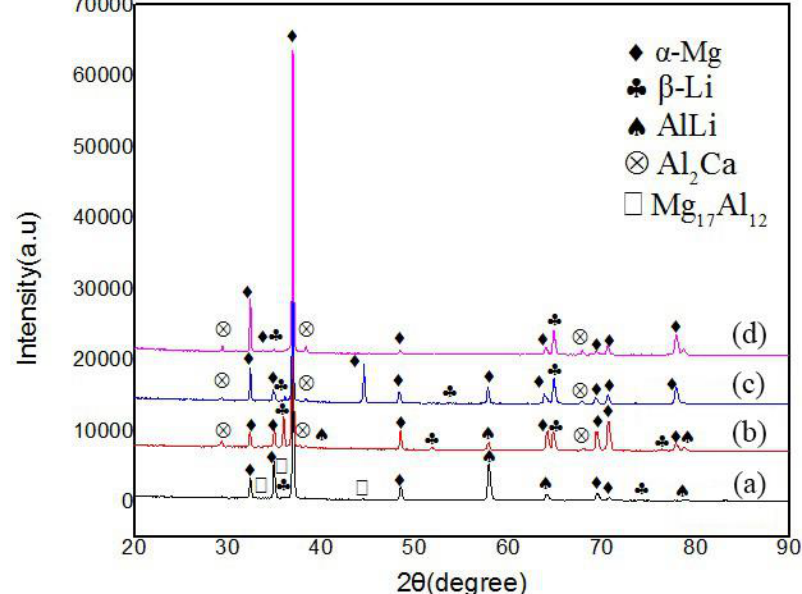
Figure 3. XRD patterns of the extruded Mg–7Li–3Al–xCa alloys: ( a ) x = 0 ( b ) x = 0.4 ( c ) x = 0.8 ( d ) x = 1.2.